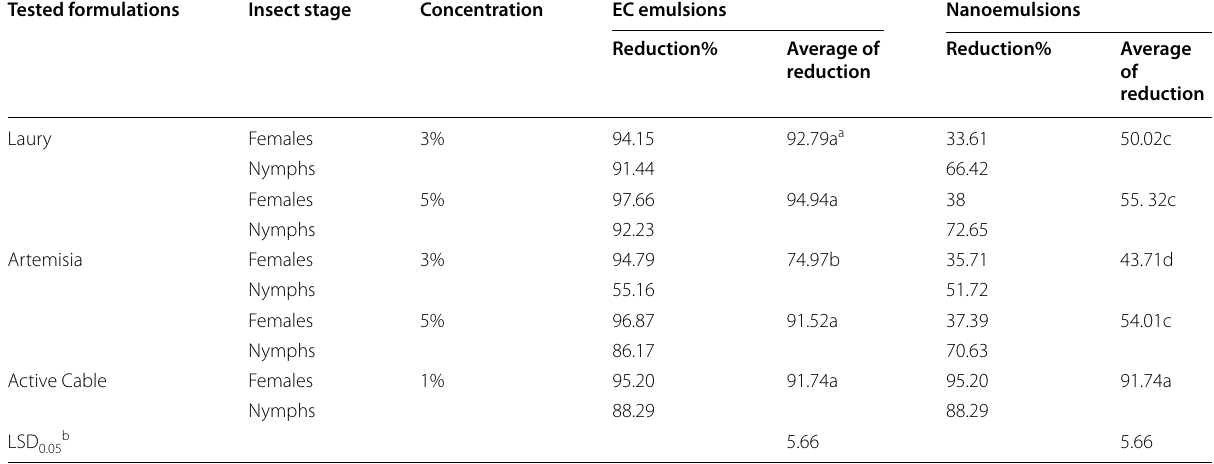
Table 6 Average percentages of reduction in insect population of Parlatoria ziziphi as a result of spraying certain essential oils as emulsions and nanoemulsions